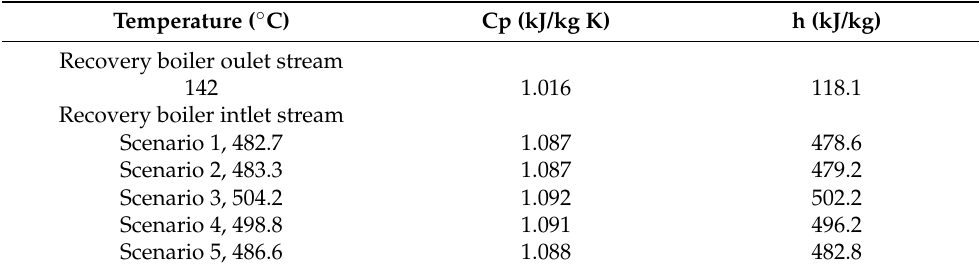
Table 5. Specific enthalpies and Cp values calculated for inlet and outlet streams of the recovery boiler. Cp values of exhaust gases were assumed to be equivalent to air. Cp (kJ/kg K) h